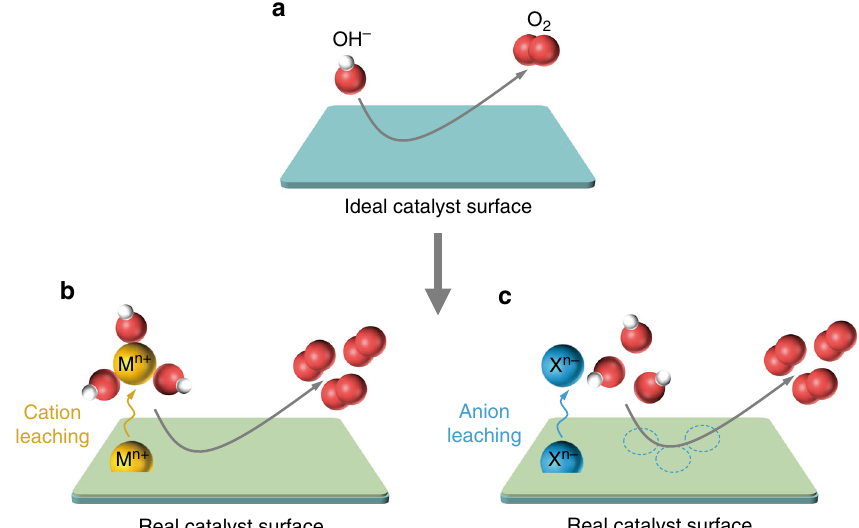
Fig. 1 Schematic description of ion leaching effects on catalyst surface during OER in alkaline media. a Ideal OER process without ion leaching on material surface. Actual b cation leaching and c anion leaching behaviors on real catalyst surface during alkaline OER, where the ion leaching effects could contribute to the adsorption of OH − reactants and thus promote OER